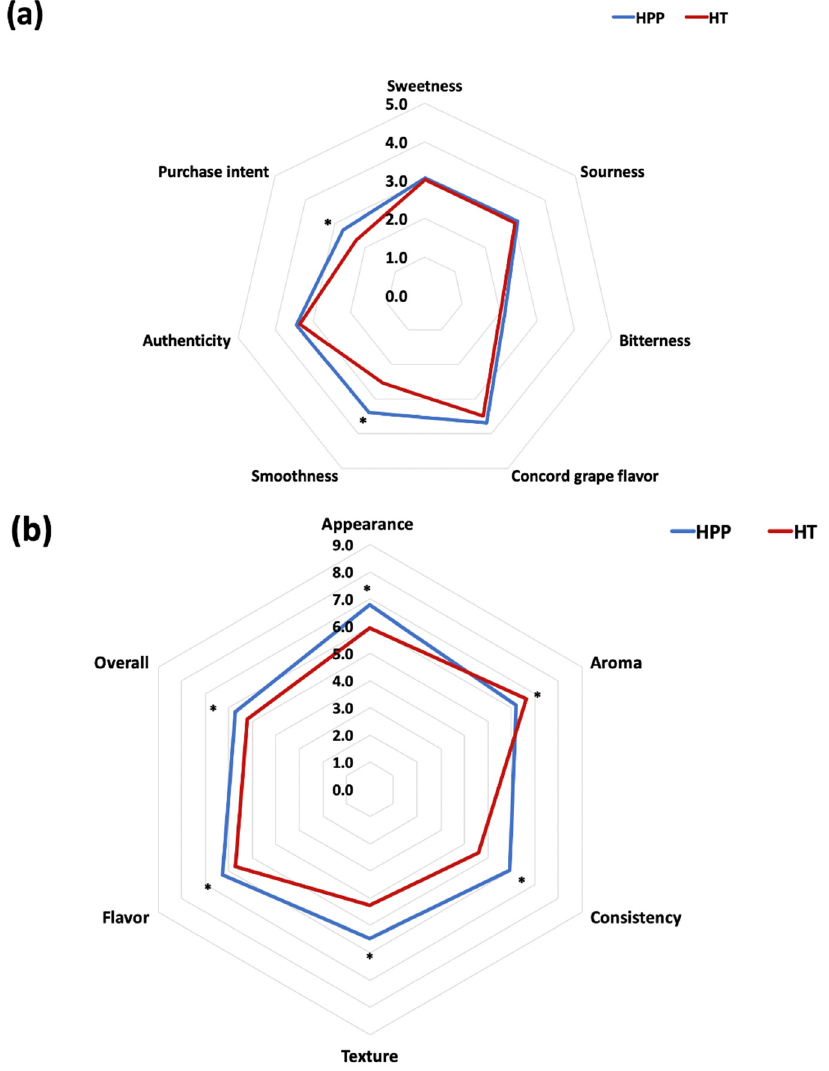
Figure 6. Sensorial attributes of HPP- (600 MPa, 3 min) and HT-treated (63 °C, 3 min) puree: intensity of different characteristics ( a ) on a 5- point hedonic scale (1 = low, 5 = high) and consumer liking ( b ) on a 9-point hedonic scale (1 = dislike it extremely, 9 = like it extremely). Denotation of “*” indicates significant difference between different treatments ( n = 101, p < 0.05).